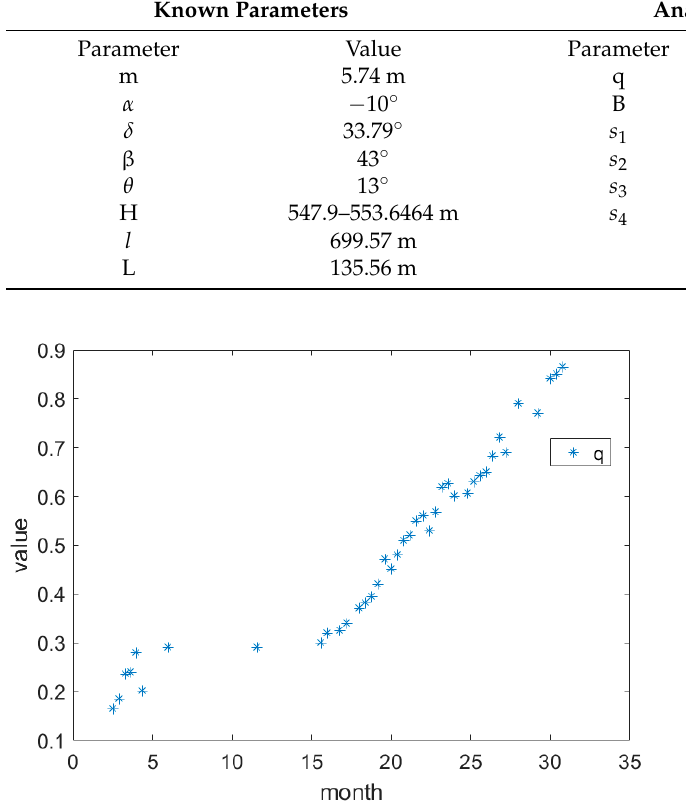
Fig 11 Figure 11. Change in the inverse dynamic subsidence coefficient with observation